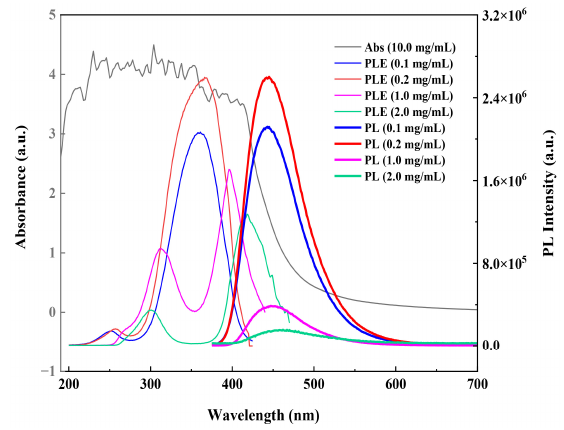
Figure 9. Spectral overlap between the absorption spectrum of 10.0 mg/mL PEI@CNDs solution and the PL spectra of 0.1, 0.2 1.0, 2.0 mg/mL PEI@CNDs solutions, in which the PL spectrum of 2.0 mg/mL sample was enlarged five times.